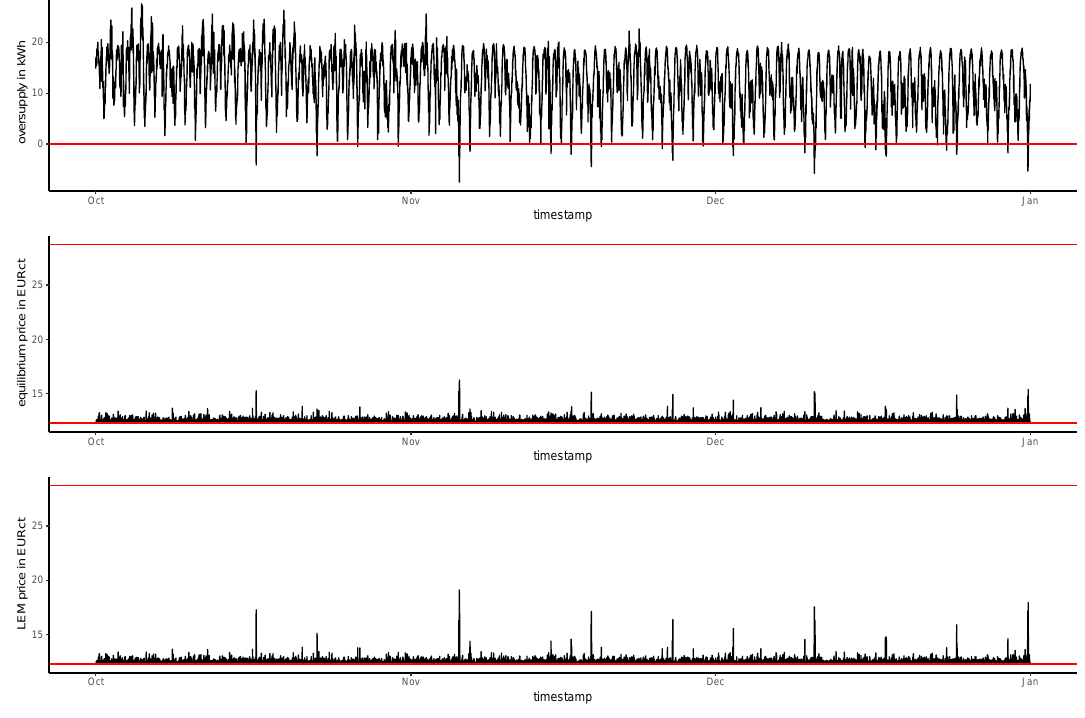
Figure 8. Market outcomes per trading period simulated with true values and an oversupply scenario. BLEMmarketSimulation (github.com/QuantLet/BLEM/tree/master/BLEMmarketSimulation)